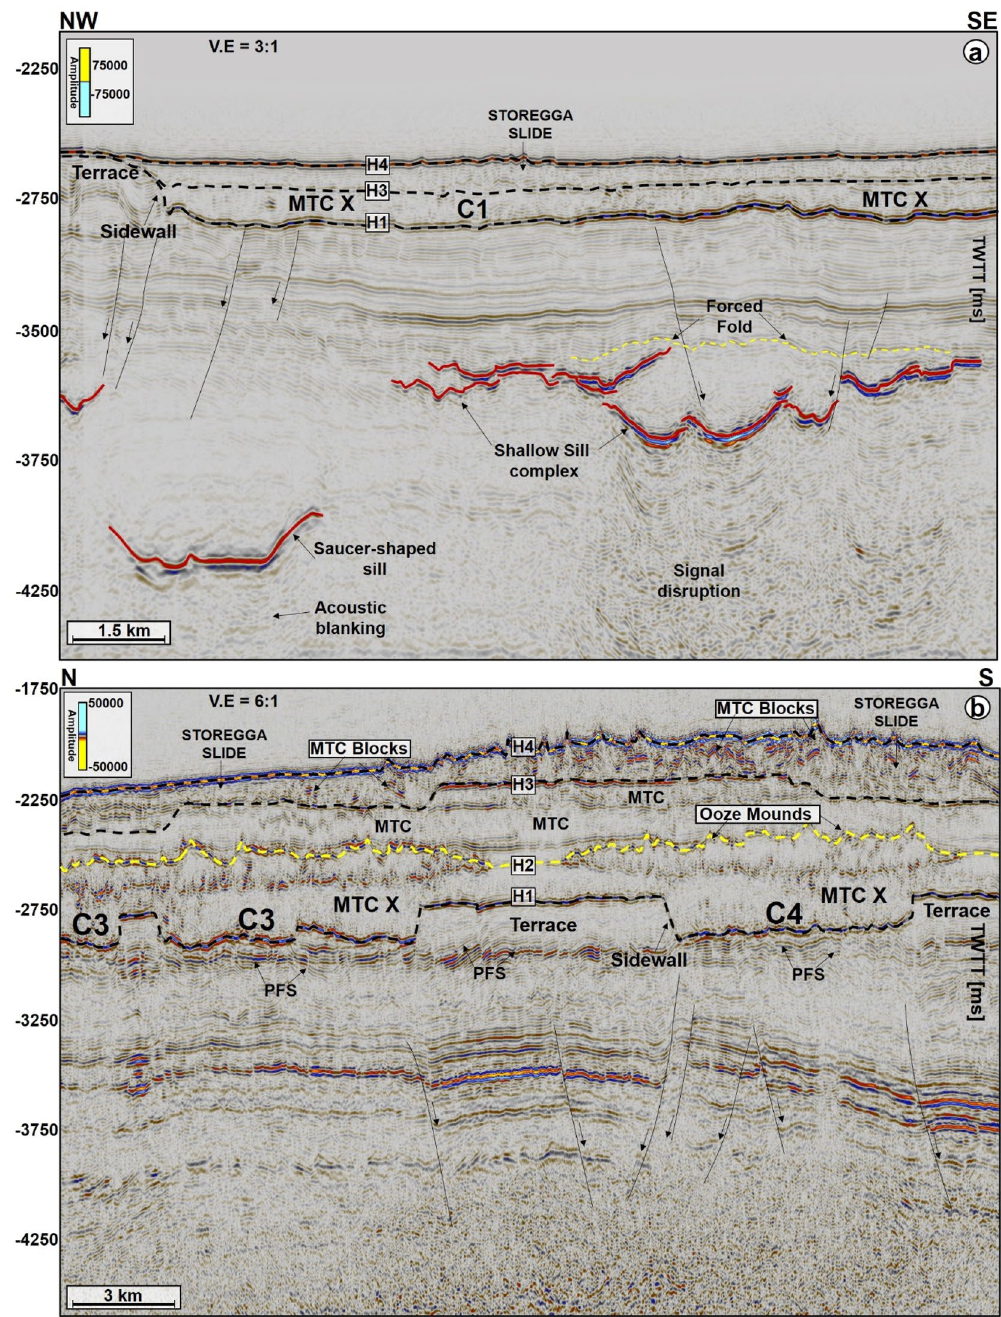
Figure 5. Seismic profiles showing the basal shear zone (BSZ) configuration of MTC X in the ( a ) SMA and ( b ) Havsule areas. The BSZ of the MTC is characterized by its rugged topography. Here, marked topographic variations on the BSZ are caused by craters, their flanking terraces (flats), and the sidewalls that connect the craters to the terraces. All these BSZ features are notably underlain by magmatic sills in the SMA area and by polygonal faults in the Havsule area. The infill of the craters varies considerably from chaotic, low-amplitude strata (reflecting debris-flow deposits in the SMA area) to a mixture of moderate to high-amplitude strata in the Havsule area. N.B: Uninterpreted seismic profiles are provided in the